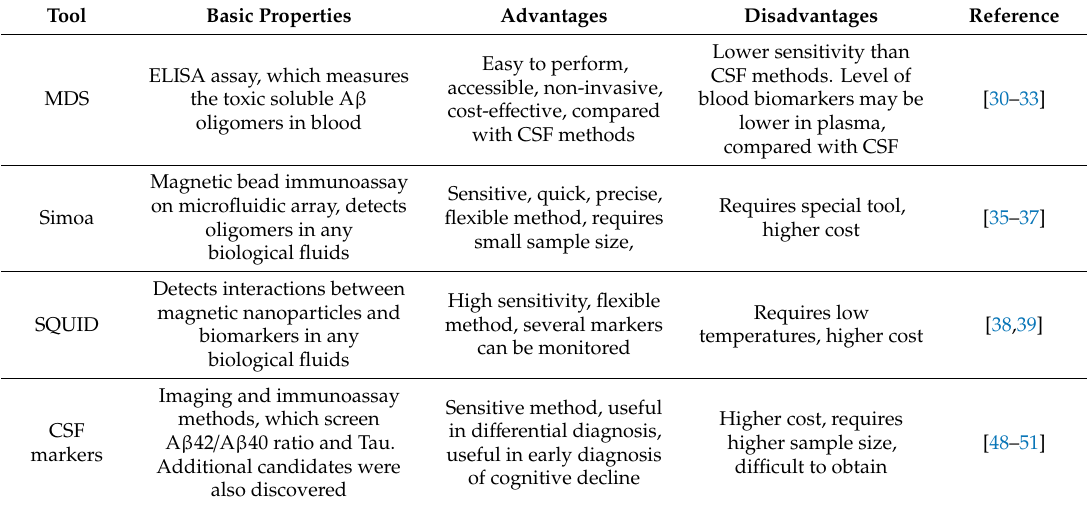
Table 3. MCI diagnosis approaches and their advantages /